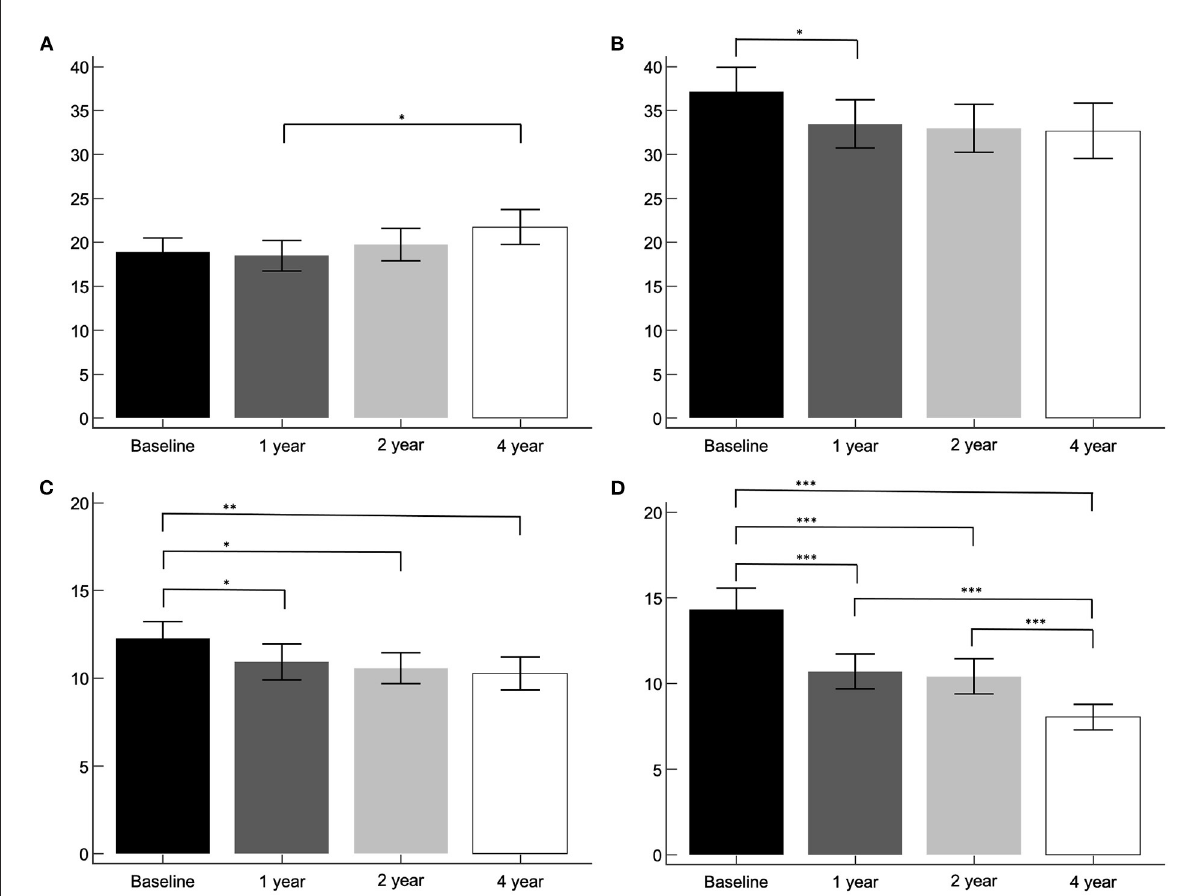
FIGURE2 The asymmetry index of the PD group. Asymmetry index by method 1, caudate (A) and putamen (B) . Asymmetry index by method 2, caudate (C) and putamen (D) . * p < 0.05, ** p < 0.01, *** p < 0.001.